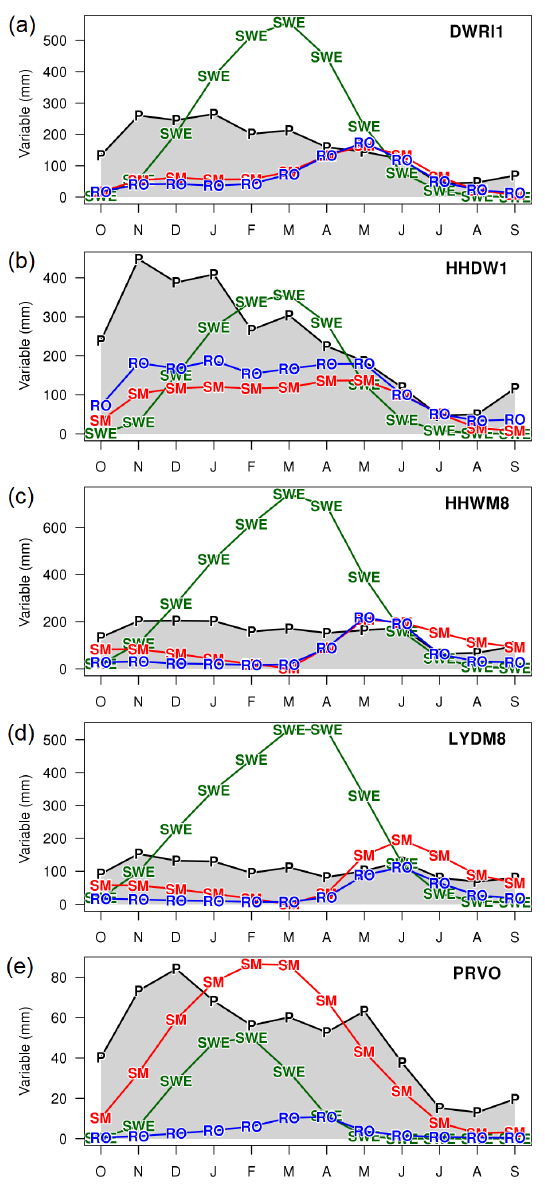
Figure 2. Corrected precipitation P (i.e., observed precipita- tion multiplied by a SCF) and simulated water balance vari- ables – active SM, SWE, and runoff (RO) – for the five study basins: (a) Dworshak reservoir inflow (DWRI1), (b) Howard Han- son reservoir inflow (HHDW1), (c) Hungry Horse reservoir inflow (HHWM8), (d) Libby dam inflow (LYDM8), and (e) Prineville reservoir inflows (PRVO). For model SM, we subtract the lowest mean monthly value of the year so that the plotted values show only the active range of